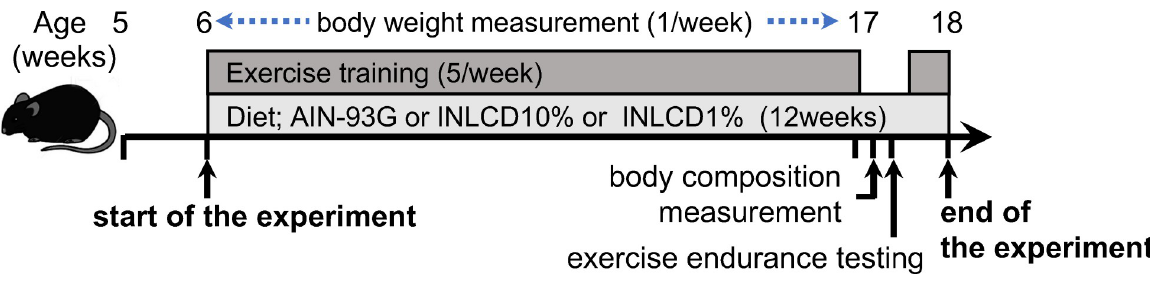
Fig 1. Timeline of the experimental